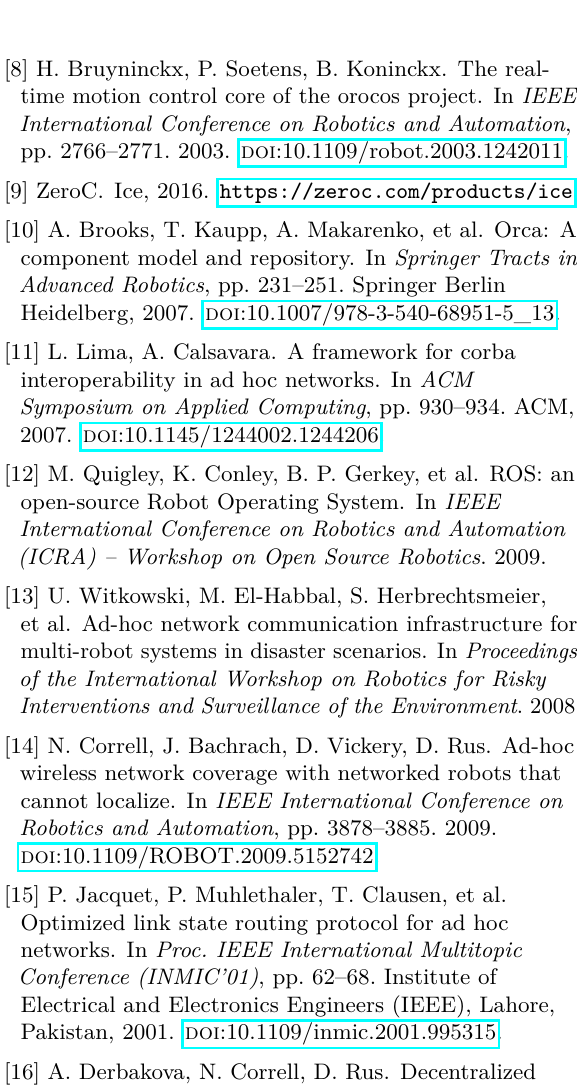
Figure 4. The frequency of plan generations for an average robot from the team that consist of: (a) 1 robot; (b) 2 robots; (c) 5 robots; (d) 10 robots.